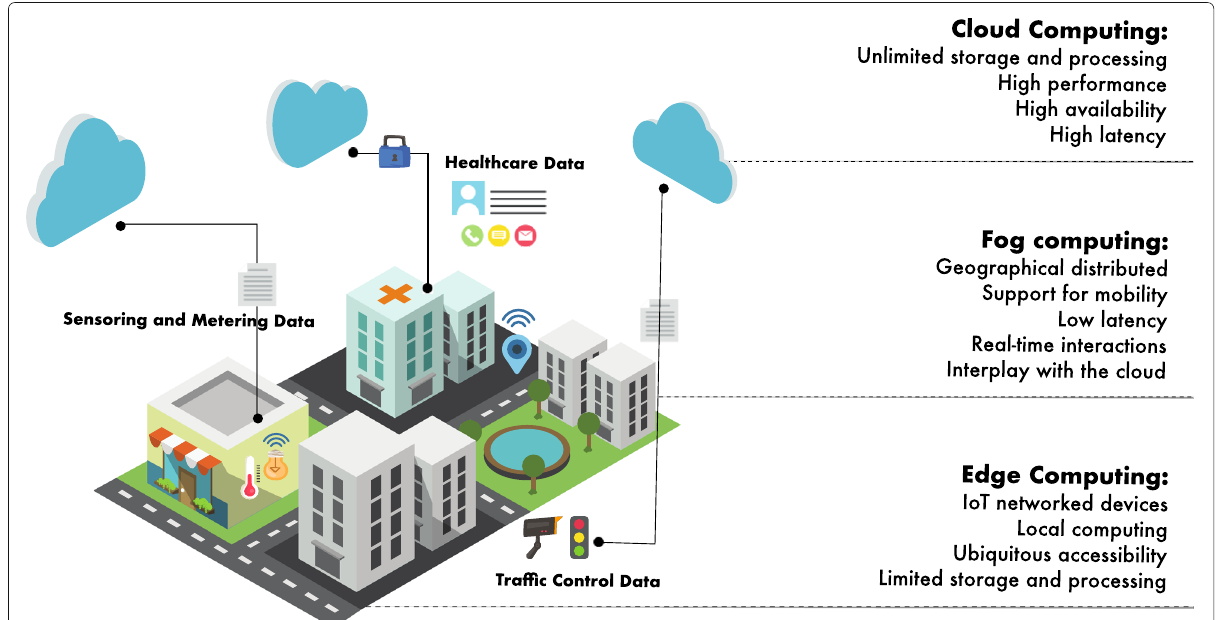
Fig. 1 IoT system integrated with cloud and fog computing applied in a smart city scenario